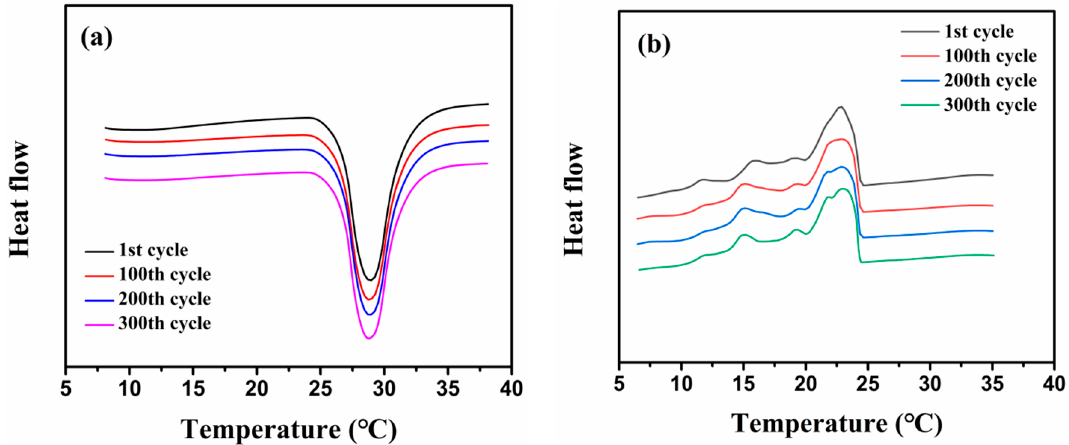
Figure 10. DSC curves of the MicroPCMs-filled epoxy composite after experiencing 1, 100, 200, and 300 heating/cooling cycles during the ( a ) melting and ( b ) freezing processes.